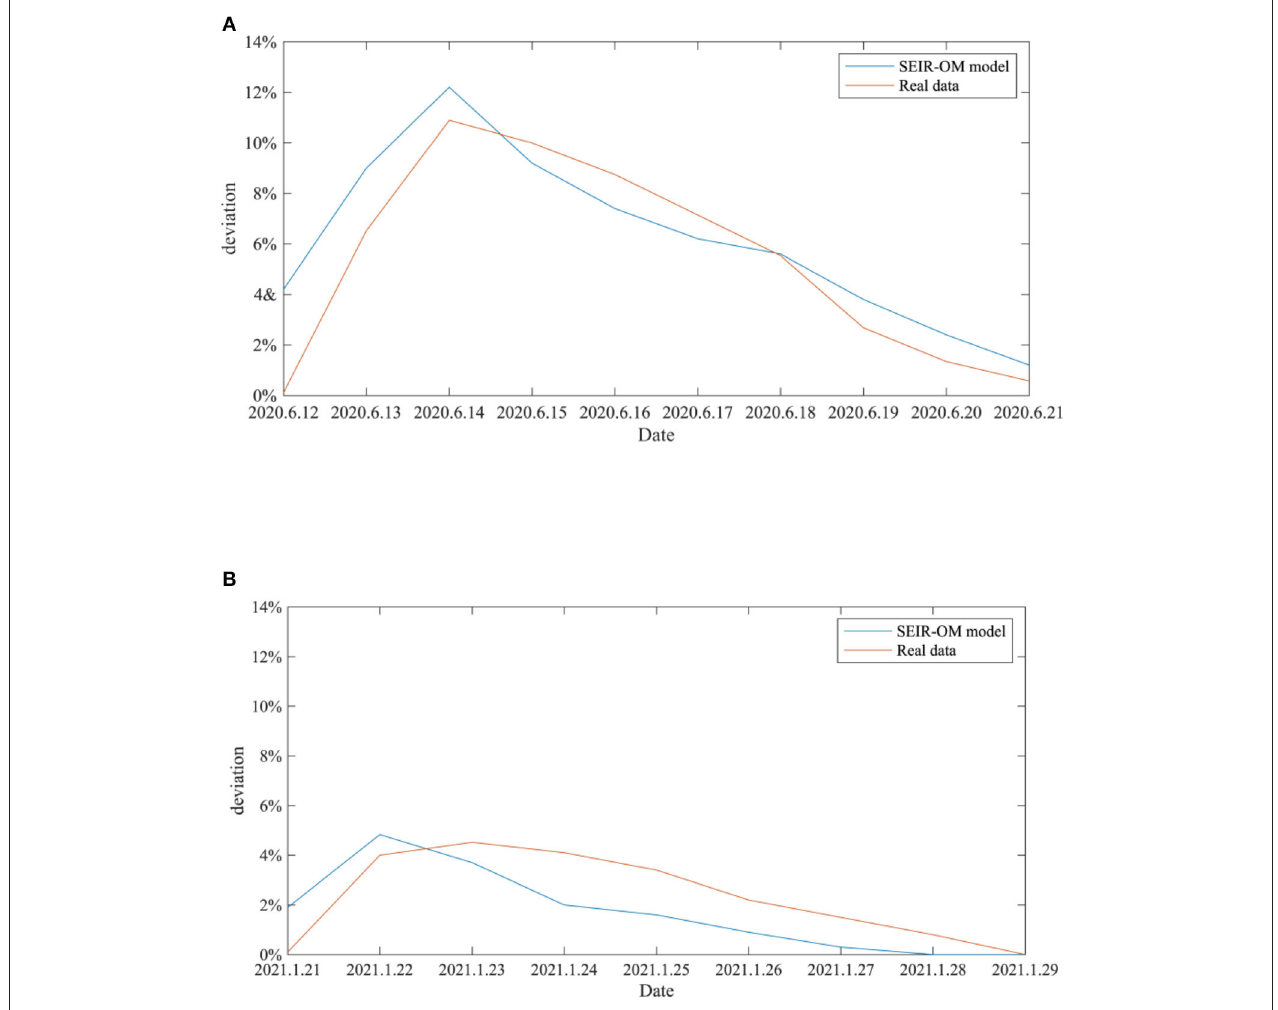
FIGURE 23 | Comparison of entire network information content deviations in two events. (A) COVID-19 was detected on the surface of the imported salmon cutting board in Beijing. (B) COVID-19 was detected on the surface of the imported cherry in